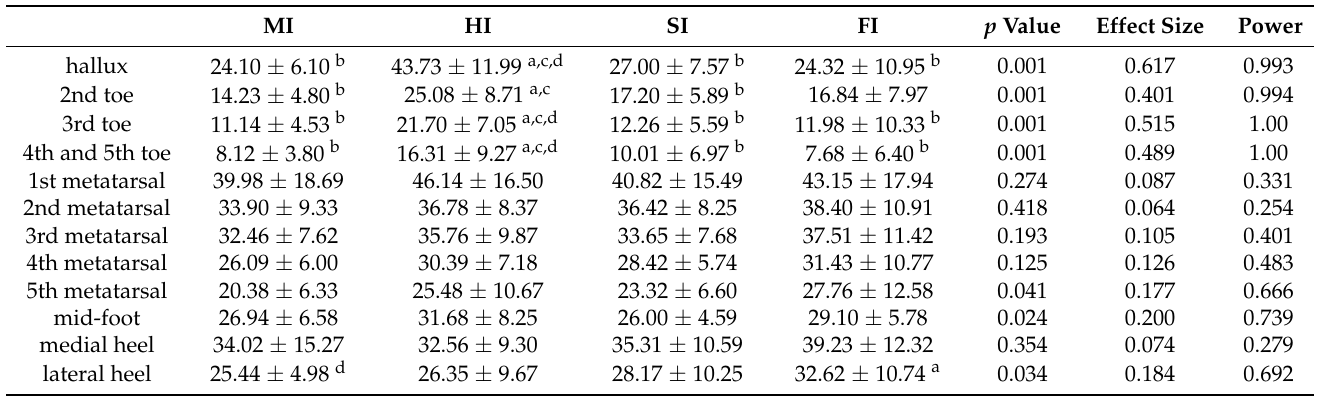
Table 4. Pressure–time integral (Kpa ×